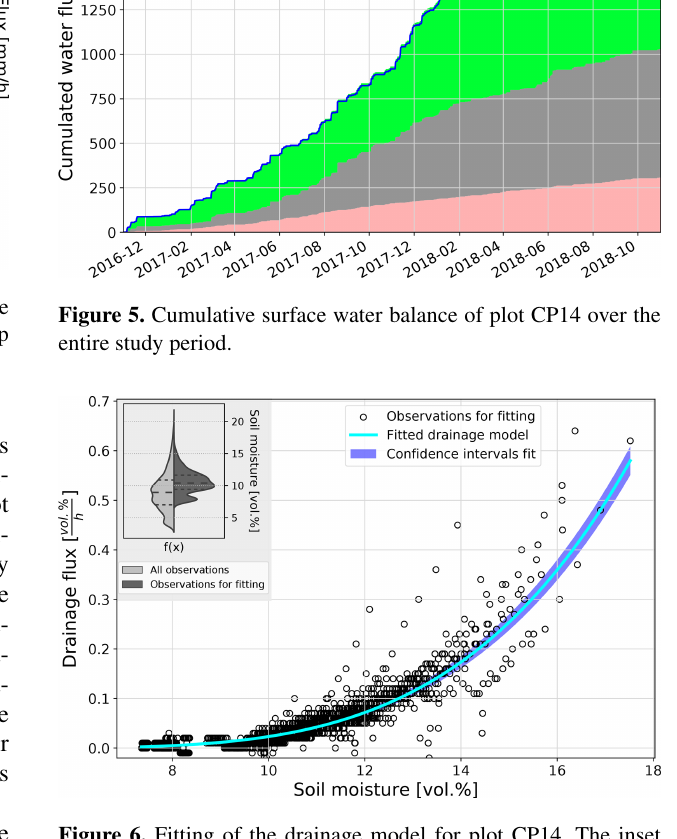
Figure 6. Fitting of the drainage model for plot CP14. The inset shows the frequency distributions of all soil moisture observations and the observations used for fitting of the drainage